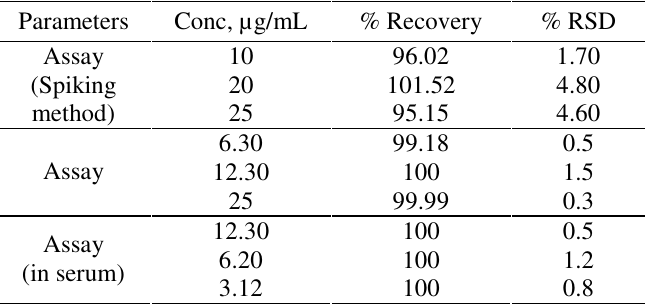
Table 1. Accuracy/recovery of sildenafil citrate